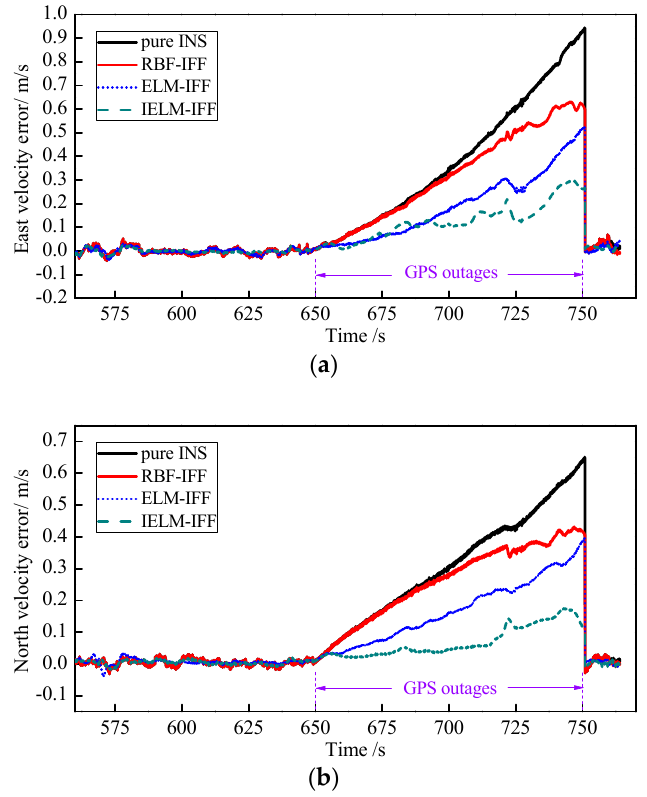
Figure 13. Curves of the east velocity error ( a ) and north velocity error ( b ) during GPS outages.